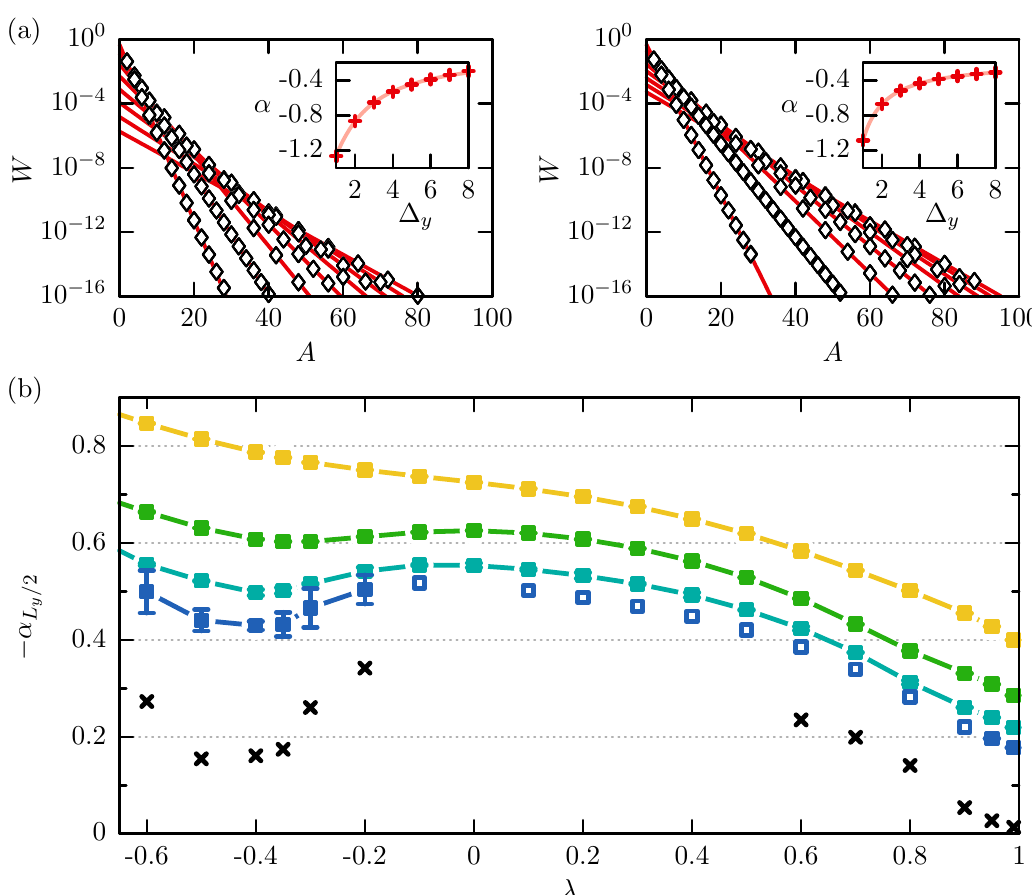
∆ Figure 7: (a) Wilson loop expectations W over enclosed area A = ∆ for λ = − 0.4 x y (left) and λ = 0.6 (right), in a 30 × 10 lattice simulated at χ = 1500. Different lines correspond to different values of ∆ . Slopes α ∆ from linear regressions to log W at y y fixed ∆ ’s (red lines) are fitted by an atan-logistic (inset, rose) (see text). (b) Slopes y α , extrapolated in χ → ∞ (except open squares: χ = 1500, error ∝ symbol L y / 2 = 3 L = 4,6,8,10 (yellow, green, cyan, blue). size) over λ , from lattices L , L x y y → ∞ are indicated without errors (black crosses) as system Estimates α ∞ for L y sizes are too small to conclusively determine the asymptotic